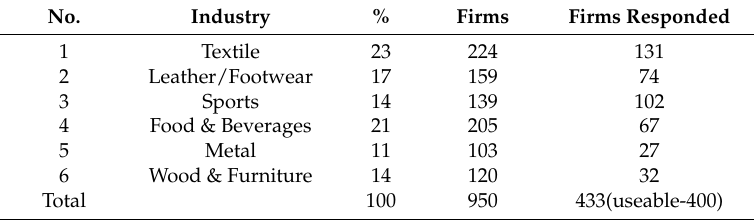
Table 1. Samples Distribution.